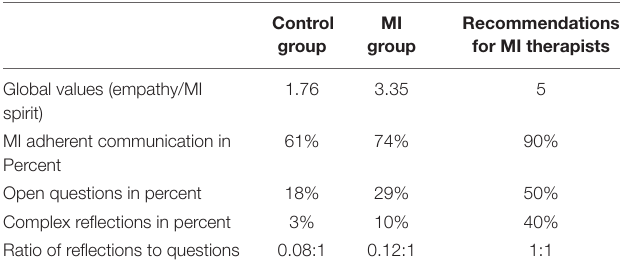
TABLE 6 | Comparison between the groups regarding MITI-d analysis and recommended basic values for MI-therapists (Moyers et al.,